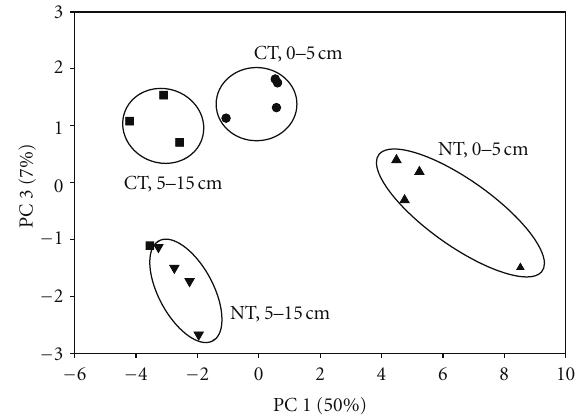
Figure 1: Principal components analysis of PLFA